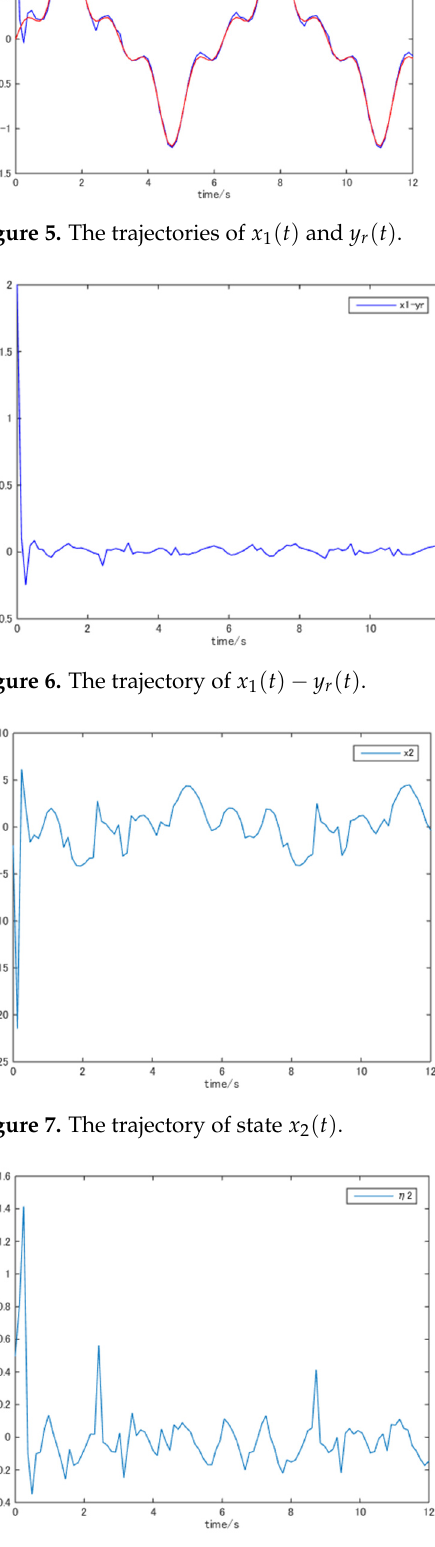
( ) t η . Figure 8. The trajectory of state η 2 ( t ) 2 ( ) t η . ( ) t η . 2 2